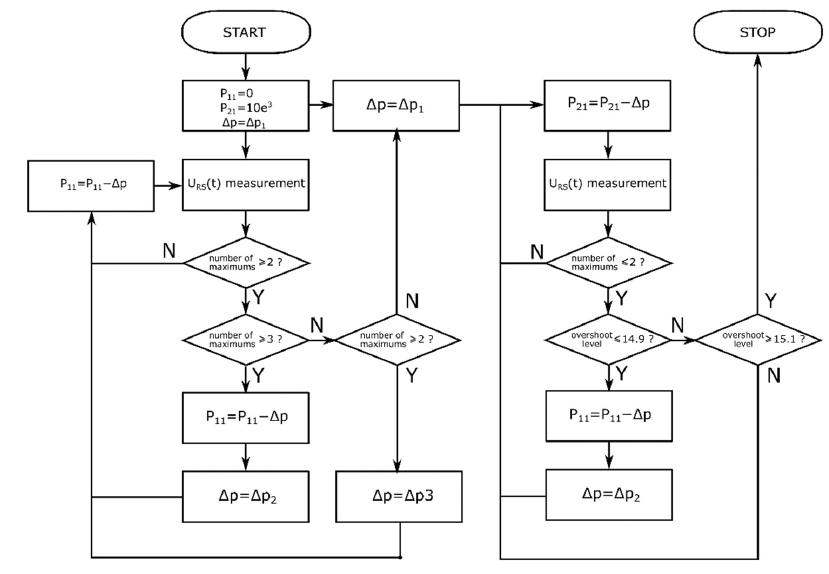
Figure 6. Adjustment algorithm—coarse adjustment.